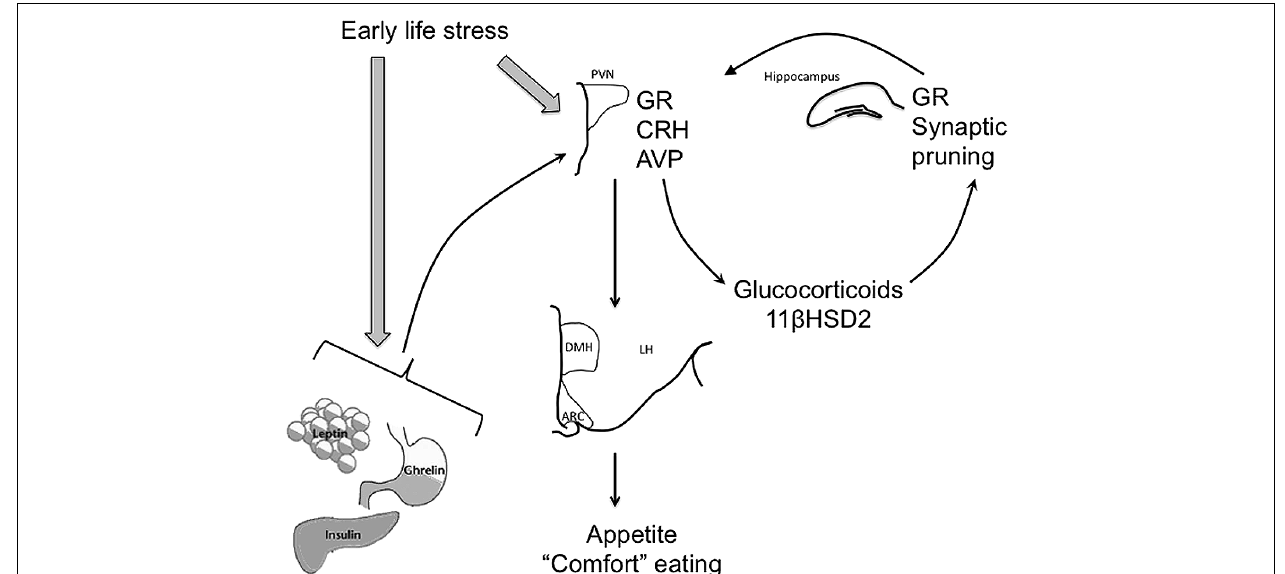
FIGURE 1 | Early life stress can influence development of the HPA axis, as well as regulation of satiety-related hormones, leptin, insulin, and ghrelin to alter feeding behavior long-term. Thus, early life stress can lead to epigenetic modification of glucocorticoid receptor (GR) expression in the hypothalamus and hippocampus and arginine vasopressin (AVP) and corticotropin-releasing hormone (CRH) in the hypothalamus, resulting in suppressed GR and increased AVP and CRH activity in response to stress later in life. Synaptic pruning in the hippocampus and circulating 11 β HSD2 are